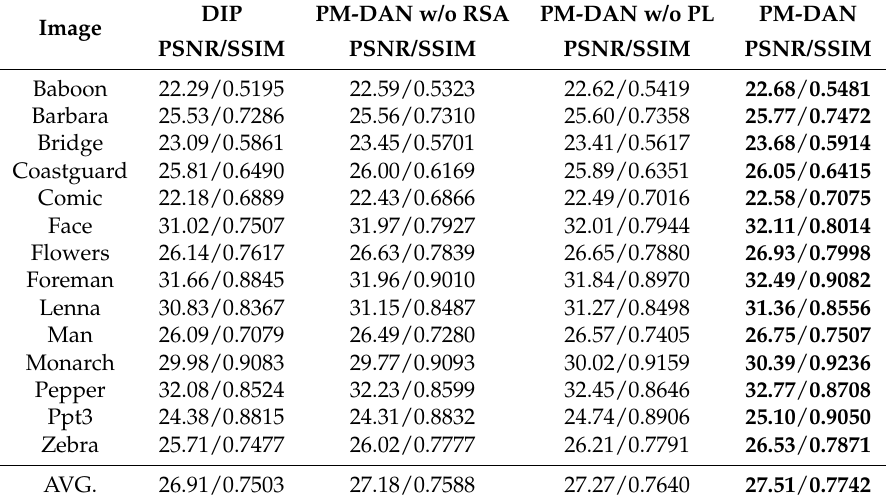
Table 2. The ablation studies to verify the influence of RSA unit and the perceptual metric on the PSNR and SSIM values of reconstruction